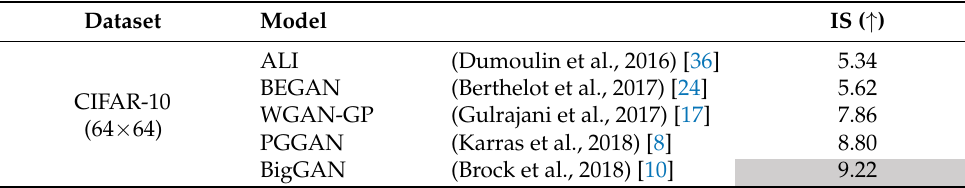
Table 7. The IS of different models trained on CIFAR-10 dataset. The higher the IS value, the better the performance.